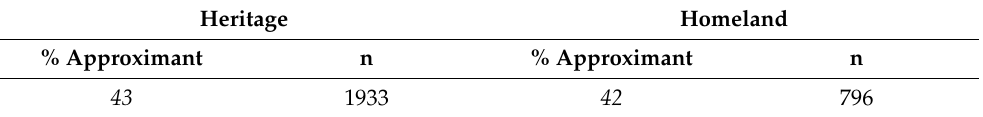
Table 4. Overall rates of use of the approximant variant between heritage and homeland